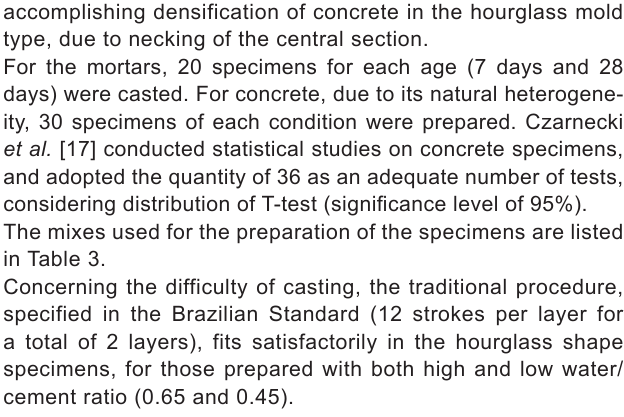
Figure 7 – Cylindrical (a) and Hourglass-like (b) FEM